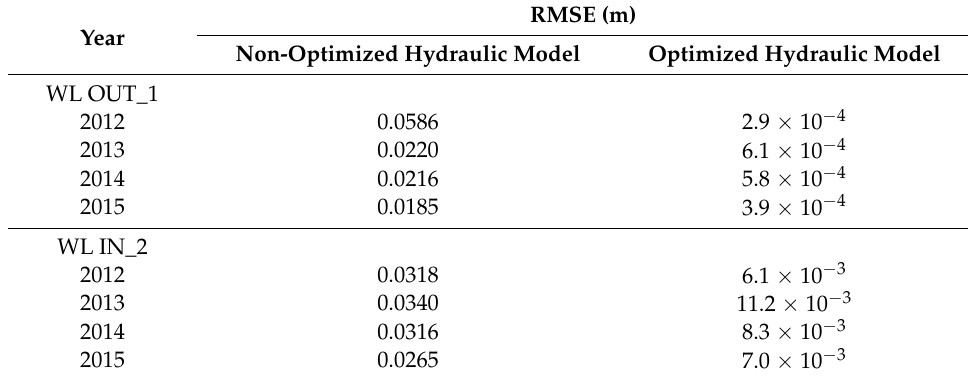
Table 4. The root mean square error (RMSE) values for both optimized and non-optimized models at WL OUT_1 and WL